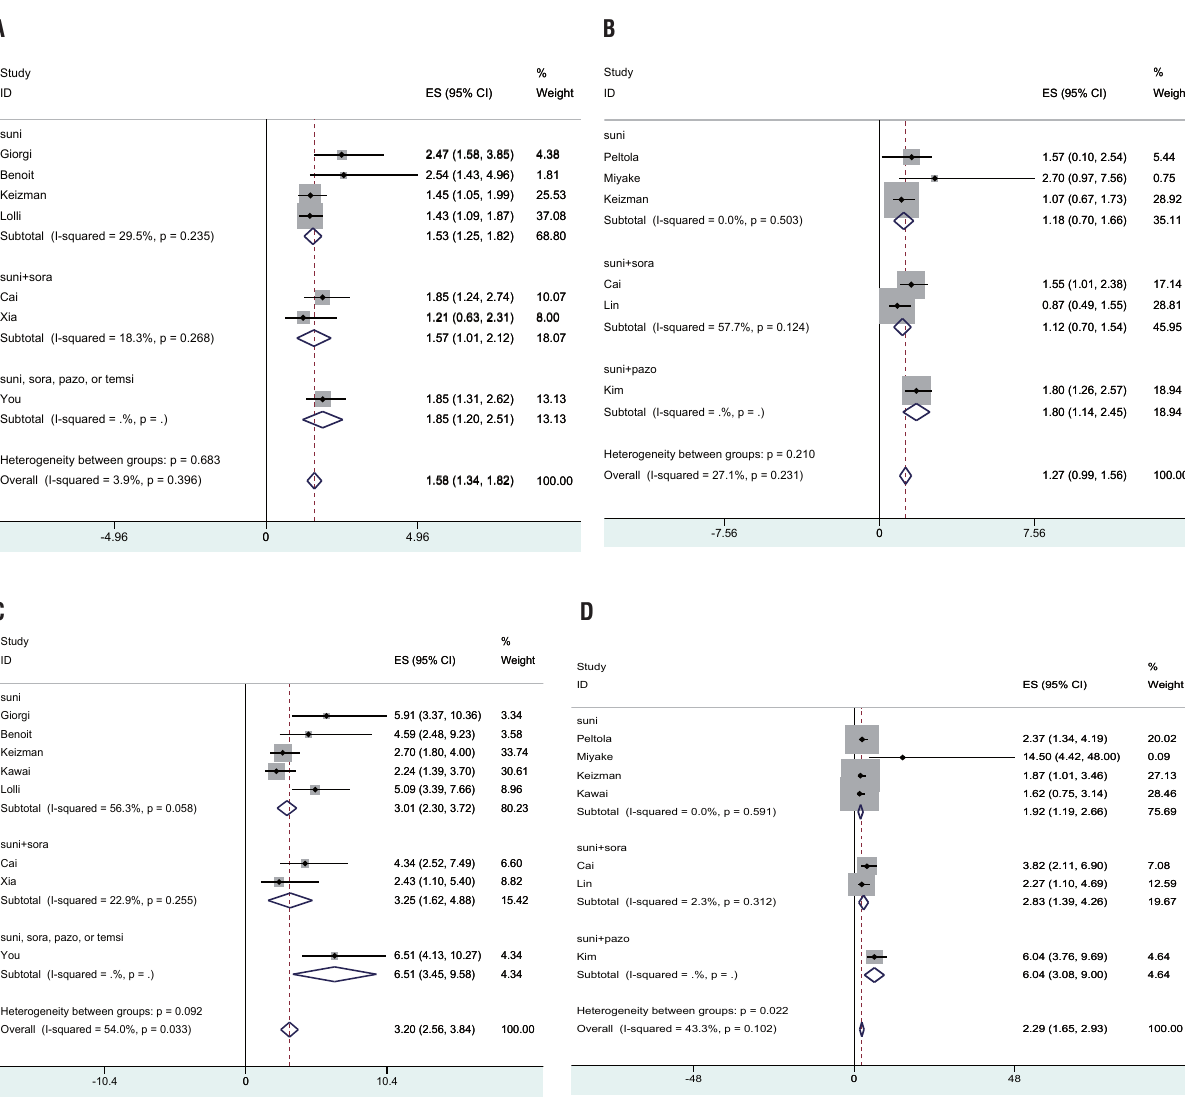
Heterogeneity between groups: p = 0.210 Overall (I-squared = 27.1%, p = 0.231)